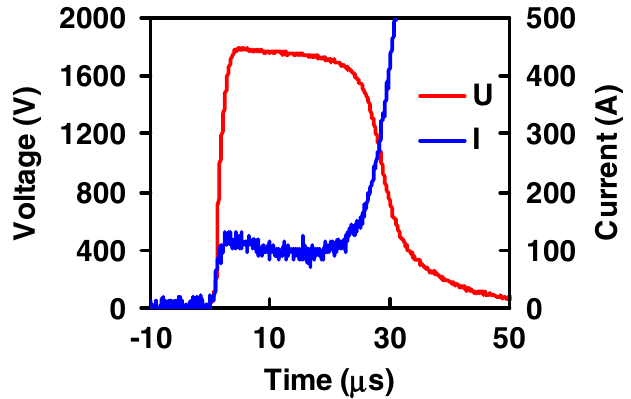
FIG. 5. (Color) Slow voltage pulse and the current in the ten- turn winding of the core made of ET3425 iron tape of thickness (cid:1) ¼ 50 (cid:6) m